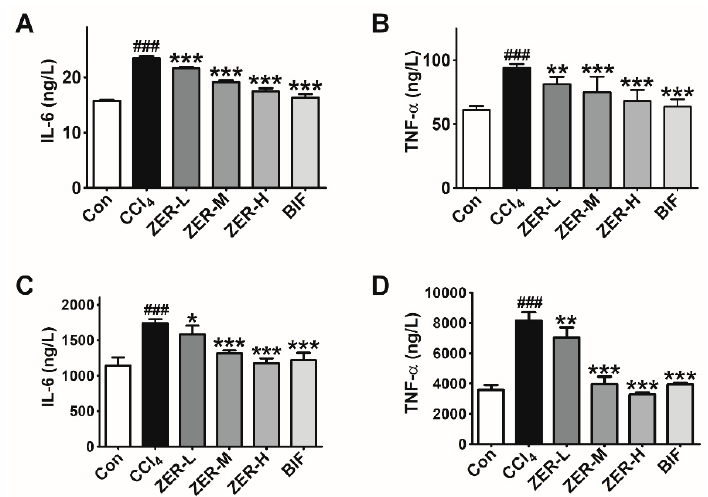
Figure 4. E ff ects of ZER on the levels of IL-6 (( A ) serum and ( C ) liver tissue) and TNF- α (( B ) serum and ( D ) liver tissue) in CCl 4 -induced ALI mice. Values represent the mean ± SD ( n = 10). ### p < 0.001 compared with the control group; * p < 0.05, ** p < 0.01, and *** p < 0.001 compared with the CCl 4 -treated